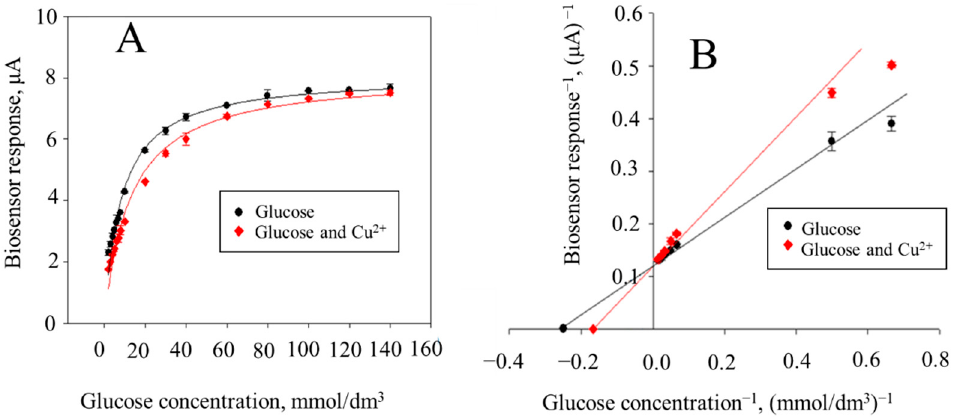
Figure 5. A form of the calibration curve ( A ) and the Lineweaver–Burk double reciprocal plot of the results obtained in the presence of Cu 2+ ( B ). Table 5. Michaelis–Menten equation parameters in the presence of reference toxicants for P. yeei – ferrocene and E. coli –ferrocene biosensor